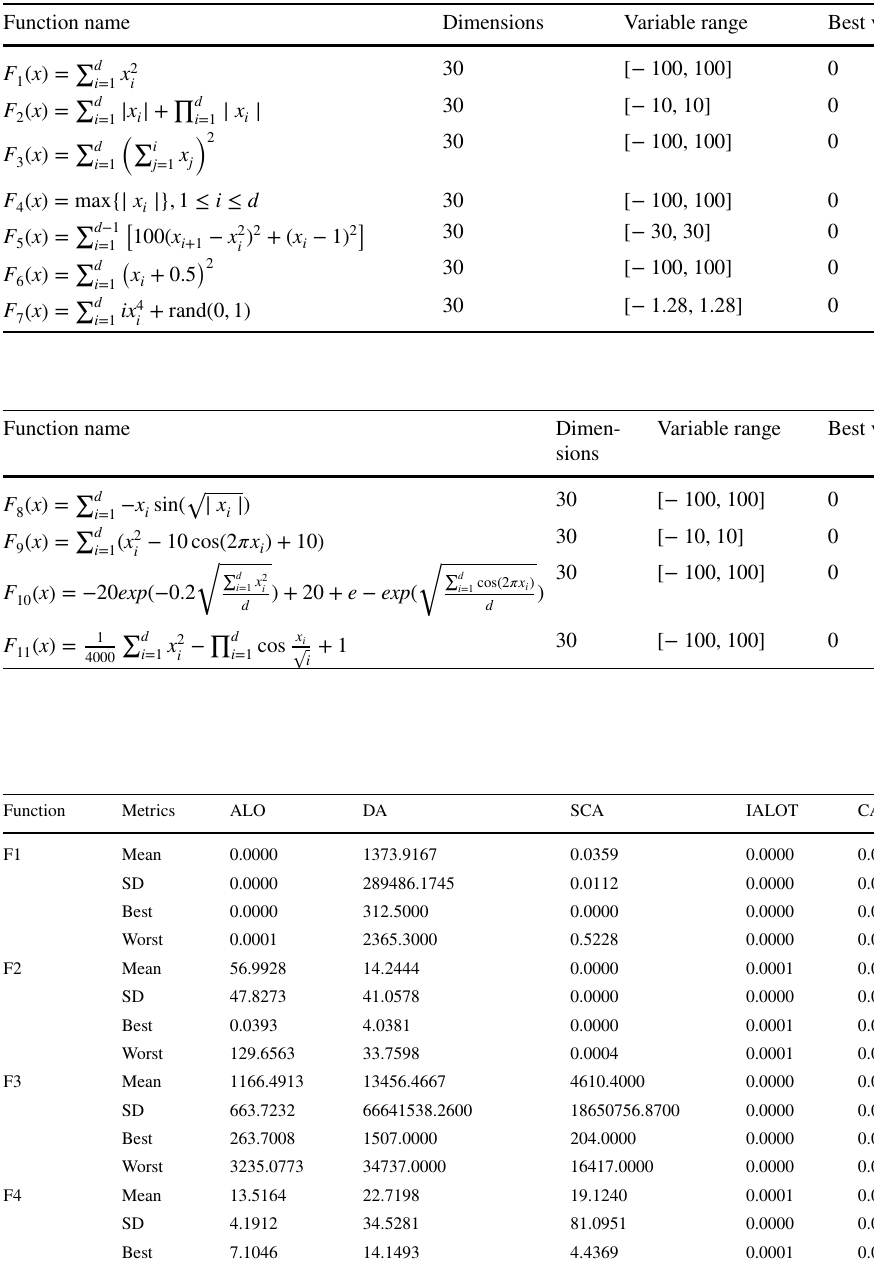
Table 1 Multi-dimensional single-peak test function